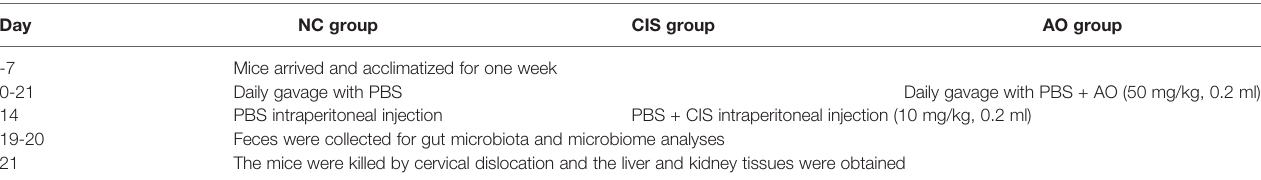
TABLE 1 | The experimental design